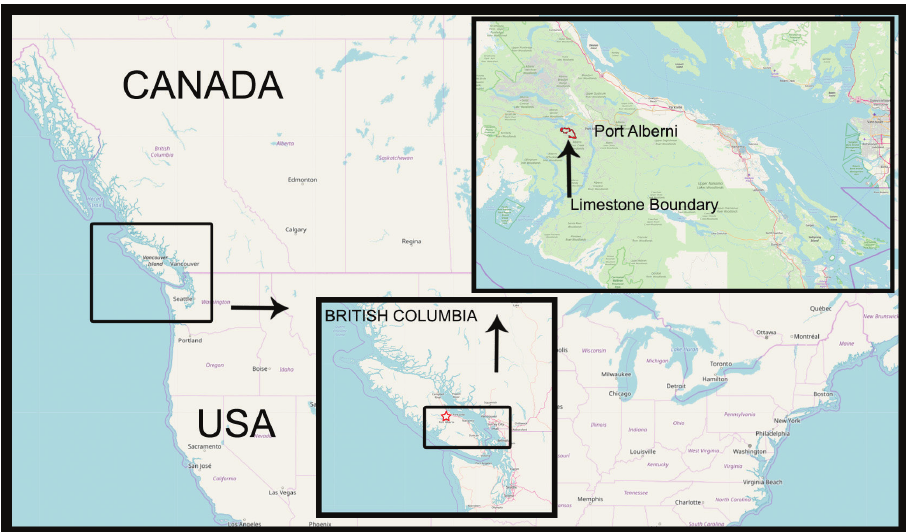
Figure 28. Map of western of North-America, highlighting in red the limestone area near Port Alberni (Vancouver Island, Canada) where Fossli Slots and Kiku Pots caves are